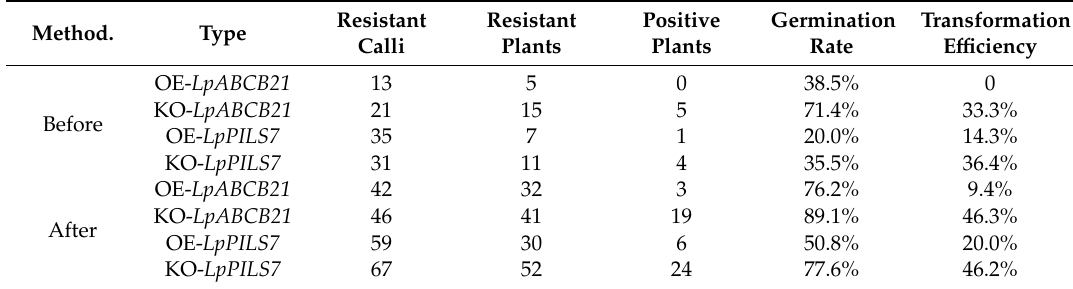
Table 2. Comparison of genetic transformation e ffi ciency before and after the improvement.